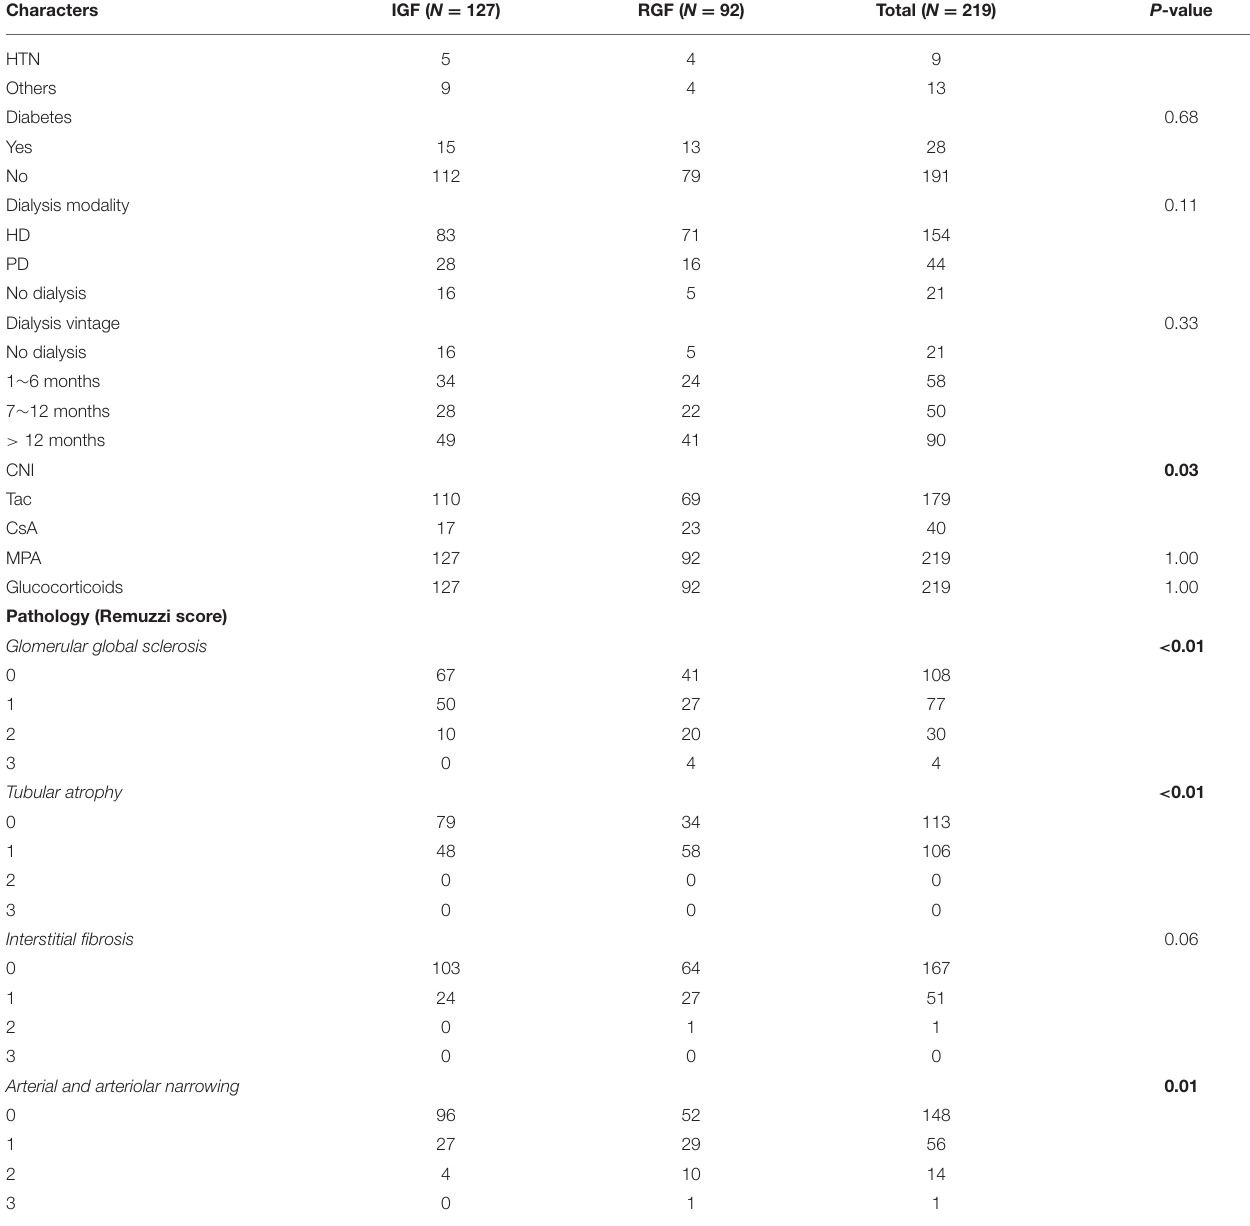
predictive accordance and accuracy; it had the lowest MAE (12.52) and RMSE (16.67) and the highest R2 (0.38) and EVS (0.47). The regression curves for stable eGFR are displayed in Figure 5A . When classifying stable eGFR into dichotomies by the cutoff value of 45 ml/min/1.73 m 2